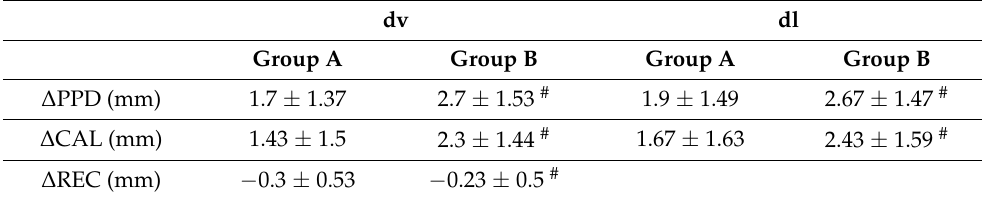
Table 3. Comparison of ∆ values (mean + standard deviation) between treatment groups: Group A (envelope flap) and Group B (triangular flap). dv dl Group A Group B Group A Group B ∆ PPD (mm) 1.7 ± 1.37 2.7 ± 1.53 # 1.9 ± 1.49 2.67 ± 1.47 # ∆ CAL (mm) 1.43 ± 1.5 2.3 ± 1.44 # 1.67 ± 1.63 2.43 ± 1.59 # ∆ REC (mm) − 0.3 ± 0.53 − 0.23 ± 0.5 #